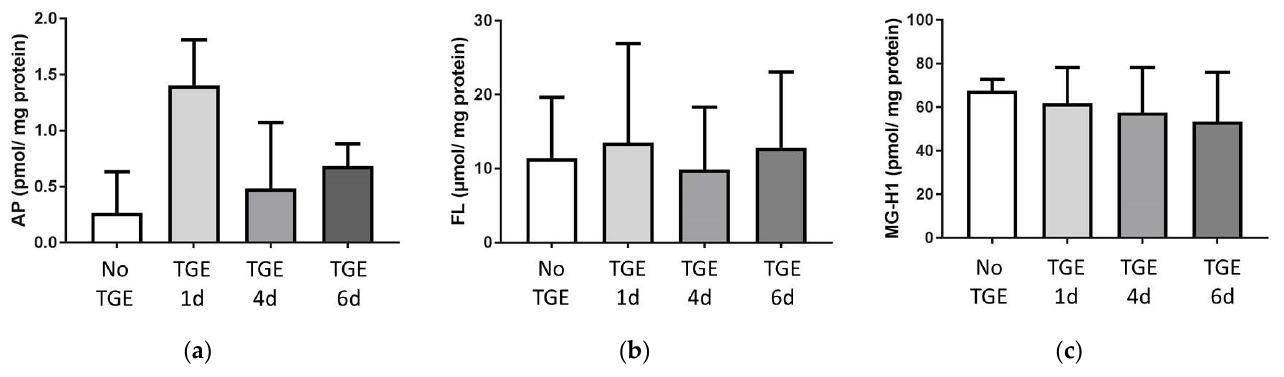
Figure 2. AGEs ( a ) argpyrimidine (AP), ( b ) fructosyllysine (FL), and ( c ) methylglyoxal-hydroimidazolone-1 (MG-H1), were not significantly increased on day 12 after initial TGE over 1, 4 or 6 days. In each experimental group the mean and standard deviation of three individual experiments is displayed.